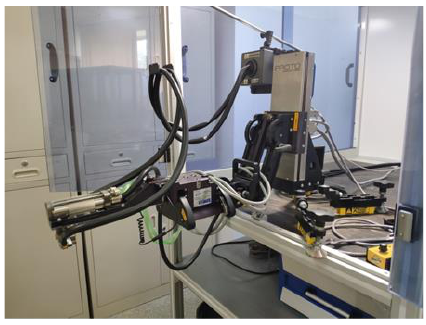
Figure 5. The Proto iXRD portable X-ray stress meter.